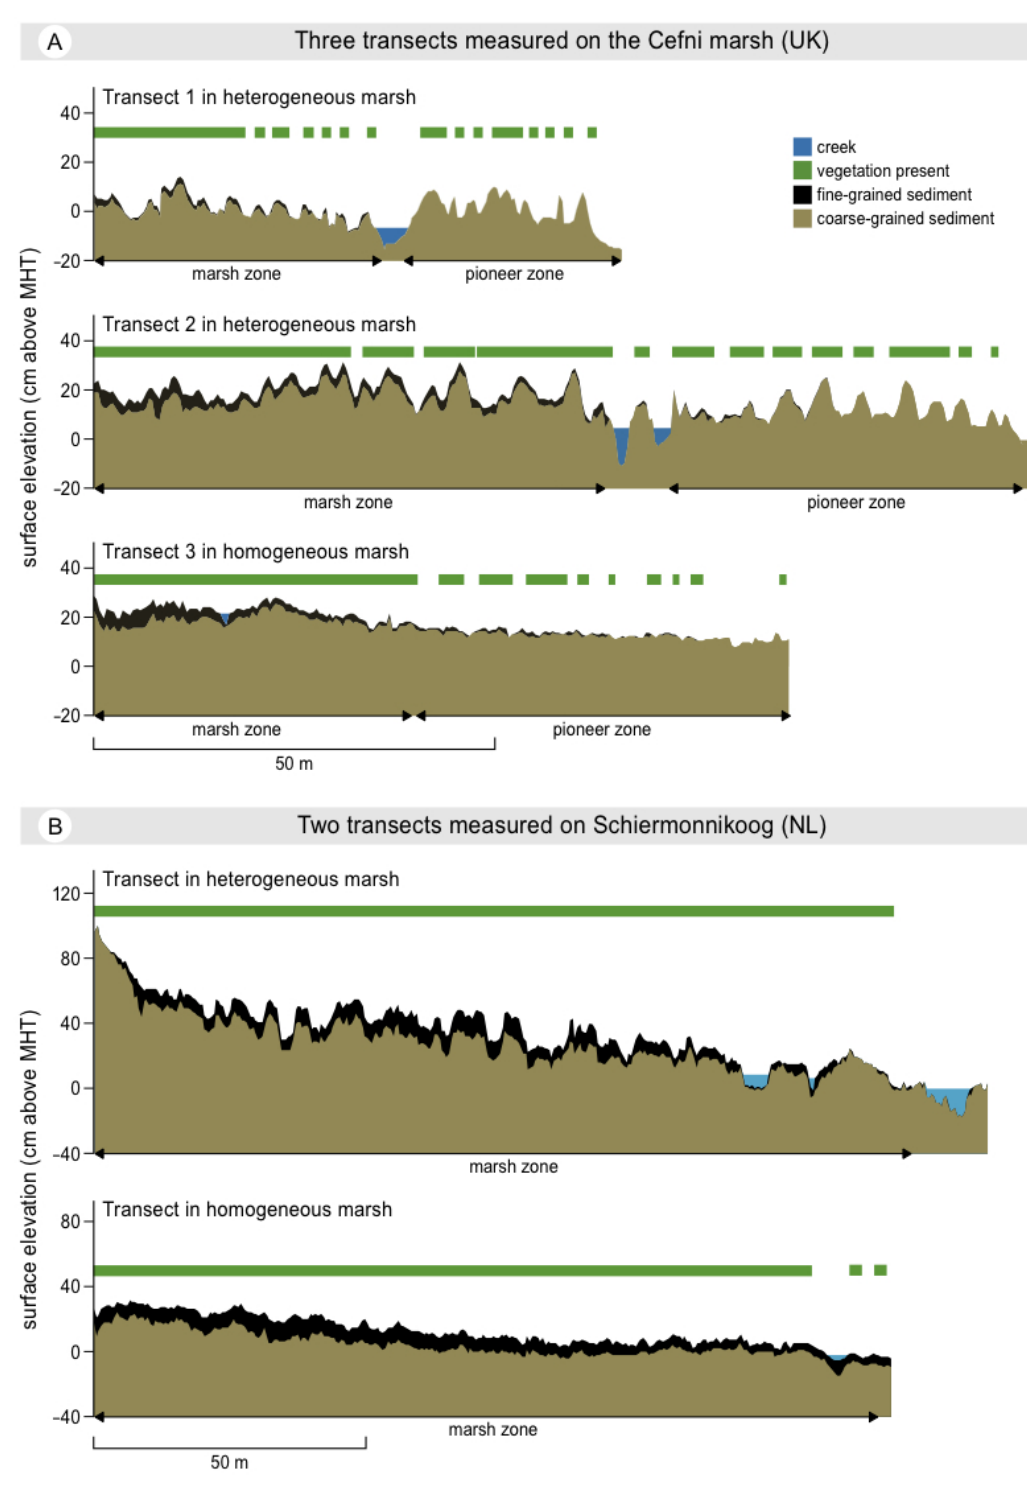
Figure 2. Transects on the Cefni marsh ( a ) and Schiermonnikoog ( b ). Light brown represents the coarse-grained sediment and dark brown represents the fine-grained sediment layer. When both hummocks and depressions were vegetated and had accumulated fine-grained sediment, we referred to it as the marsh zone. When vegetated hummocks were located on the bare intertidal flats, we referred to it as pioneer zone.